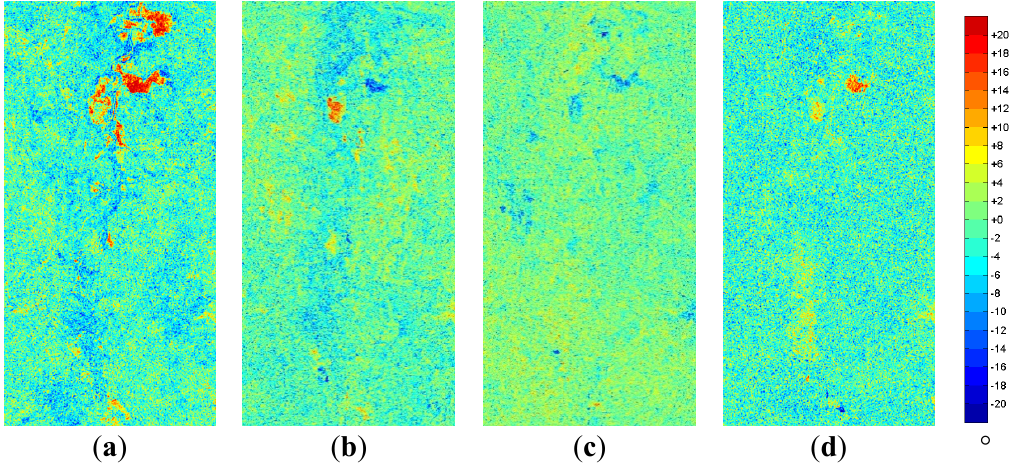
Figure 6. Cloude-Pottier dominant alpha changes between sequent acquisitions in